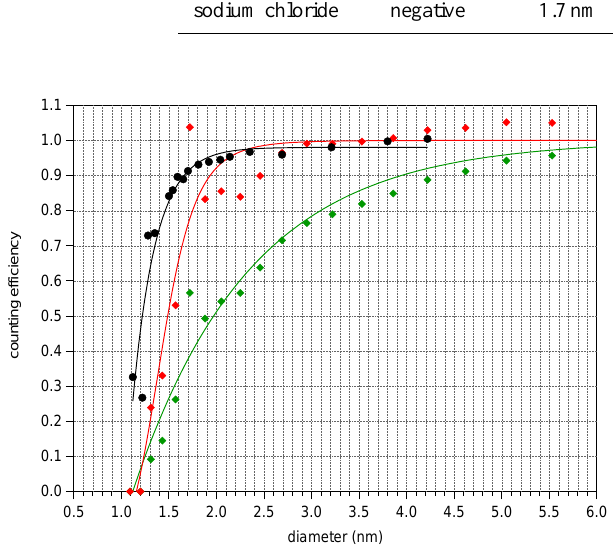
Fig. 9. Detection efficiencies of DEG CPC 1 before correcting for internal losses (green symbols) and after the correction (red sym- bols). As a comparison the (uncorrected) data from the PSM 2 from Fig. 7c is shown here in black.